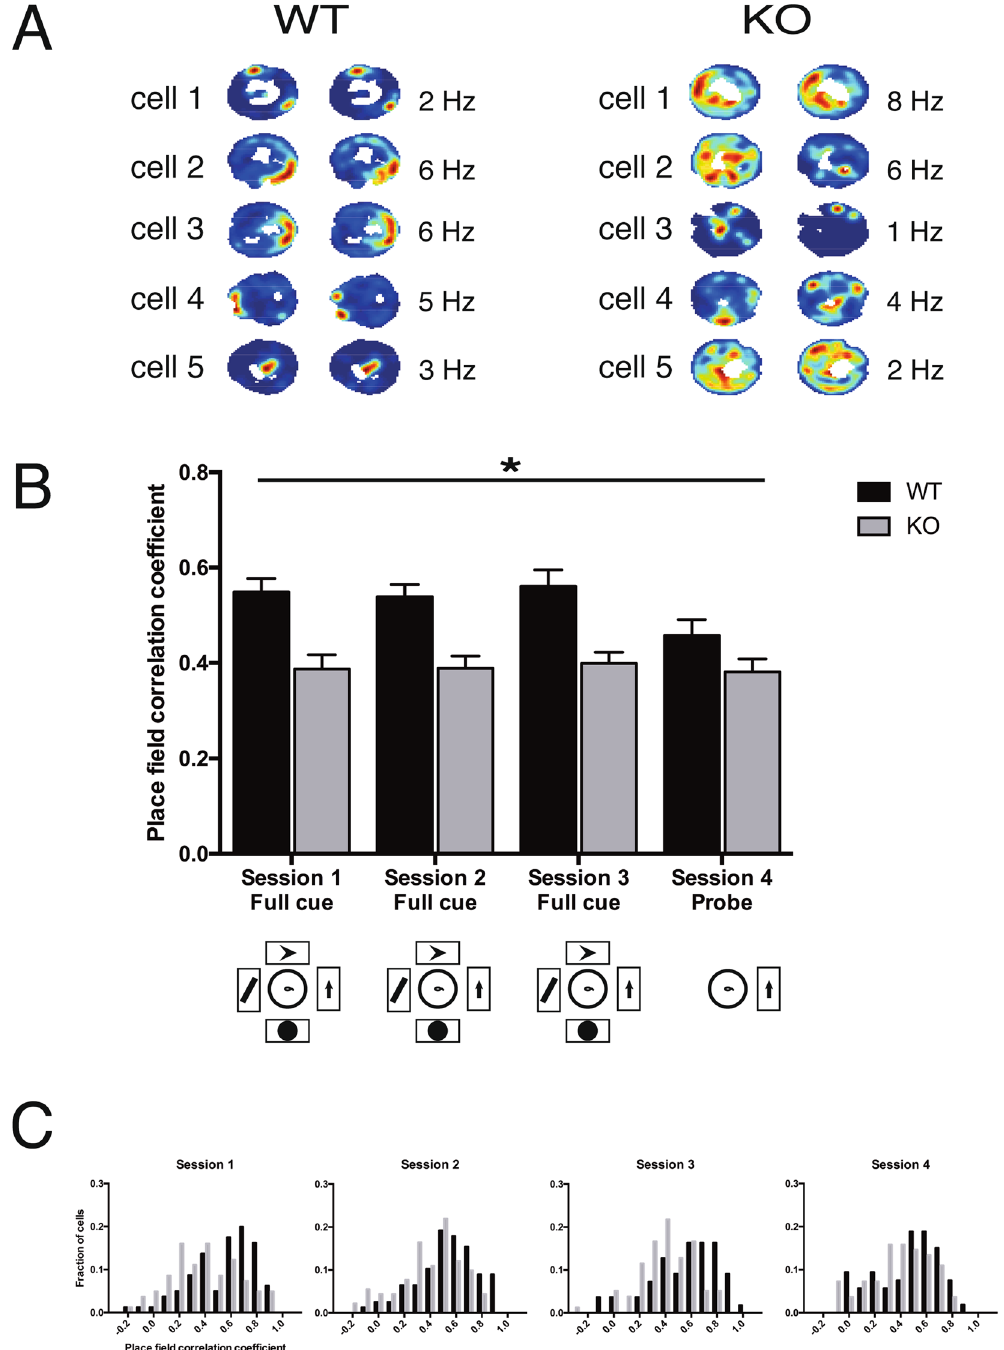
Figure 3. Stability of firing rate maps within sessions. ( A ) Example WT and KO firing rate maps (selected across all mice and sessions), split between the first (left panels) and second (right panels) halves of each recording session, to illustrate the stability of each map. Each heat map is scaled by the maximum firing rate (indicated in Hz) of the cell within that session. Areas of the arena that were not visited during the recording session are marked in white. ( B ) Correlation of WT (black) and Fmr1 -KO (gray) firing rate maps. Data are represented as mean ± SEM. Session 1: WT 80 fields, mean = 0.55, SEM = 0.028; KO 81 fields, mean = 0.39, SEM = 0.03. Session 2: WT 78 fields, mean = 0.54, SEM = 0.03; KO 91 fields, mean = 0.39, SEM = 0.03. Session 3: WT 55 fields, mean = 0.56, SEM = 0.03; KO 78 fields, mean = 0.40, SEM = 0.02. Session 4: WT 53 fields, mean = 0.46, SEM = 0.03; KO 82 fields, mean = 0.38, SEM = 0.03. ( C ) Distributions of the stability of WT (black) and Fmr1 -KO (gray) pyramidal cells. * P < 0.0001 main effect of genotype (two-way genotype x session ANOVA: F 1,590 = 46.34). There was no effect of session and no interaction